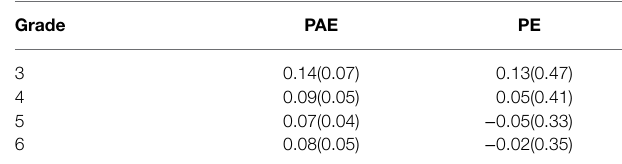
TABLE 1 | Means and SEs for Prediction Error and Percent Absolute Error by grade